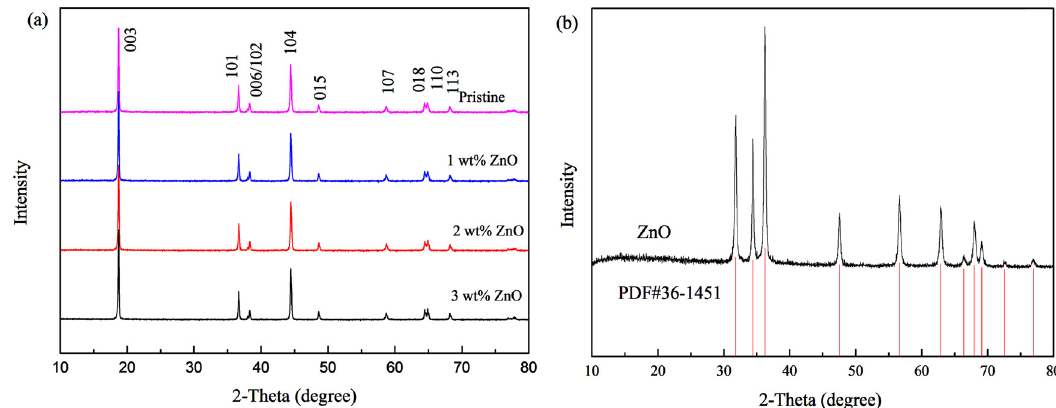
Figure 5: ( a ) XRD patterns of the pristine and ZnO - coated LiNi 0.8 Co 0.15 Al 0.05 O 2 , ( b ) standard XRD pattern of ZnO.